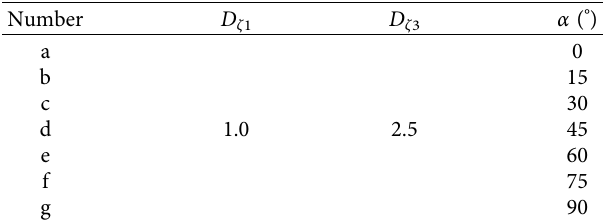
Table 3: Simulation plan with different angles of principal stress. Number D ζ